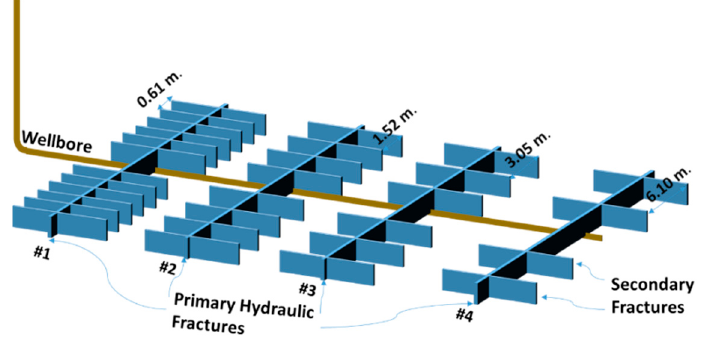
Figure 14. A simulation model for a multifractured well with secondary fractures.